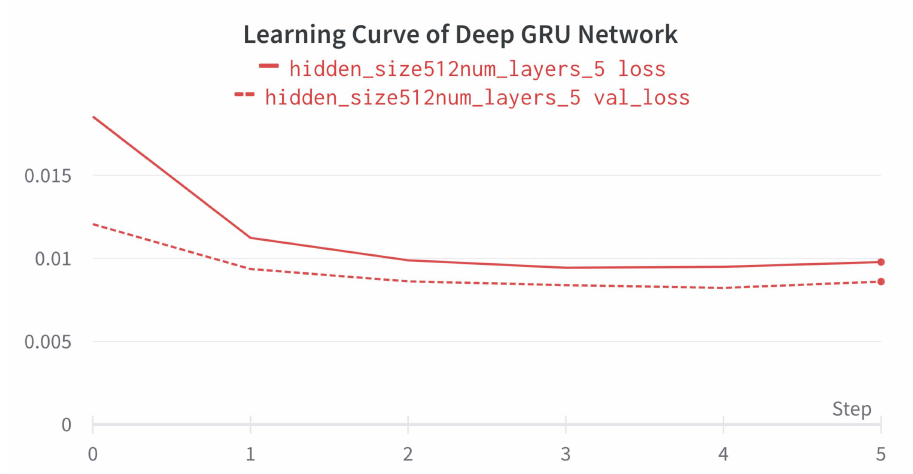
Figure 10. Learning Curve of proposed Deep GRU model with training loss and validation loss.